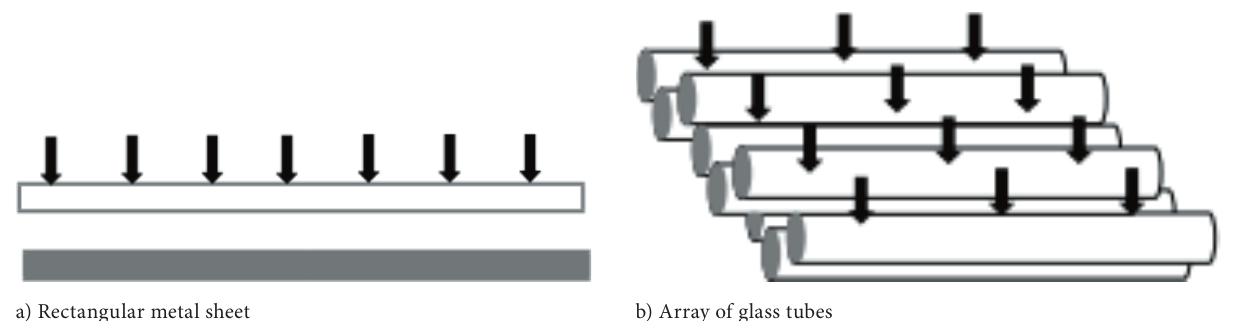
Figure 2. Th is schematic fi gure shows the diff erent types of reaction cells that were designed and developed in the study. (a) rectangular metal and glass sheet with the reactive monomer liquid in the space between (b) an array of glass tubes with closed-off ends, with the reac- tive monomer liquid enclosed in the